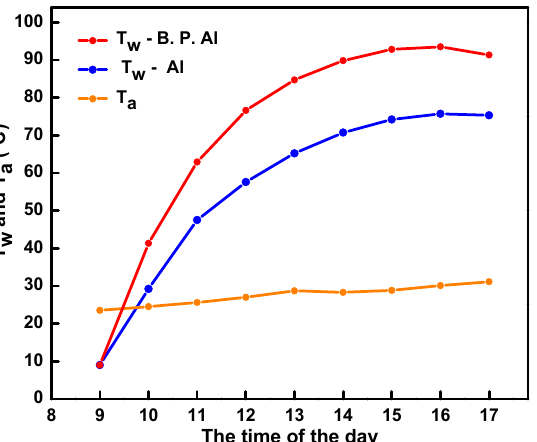
Figure 7. Water and ambient temperatures (T w and T a ) vs. time of day for Al and B. P. Al contain- ers, Sunny Day, Date: 26 September 2021, Amman, Jordan.